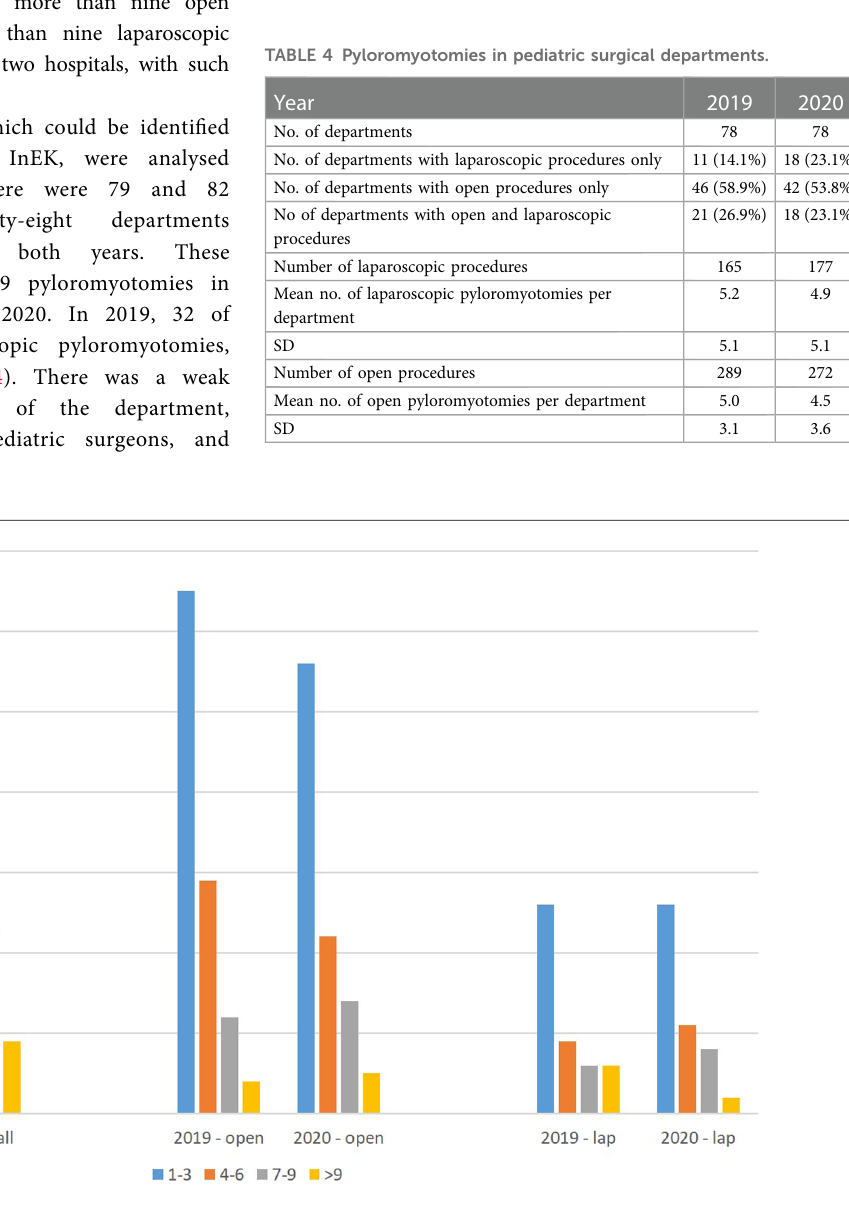
FIGURE 2 Number of procedures per hospital ( n =129 hospitals in 2019, n =125 hospitals in 2020).